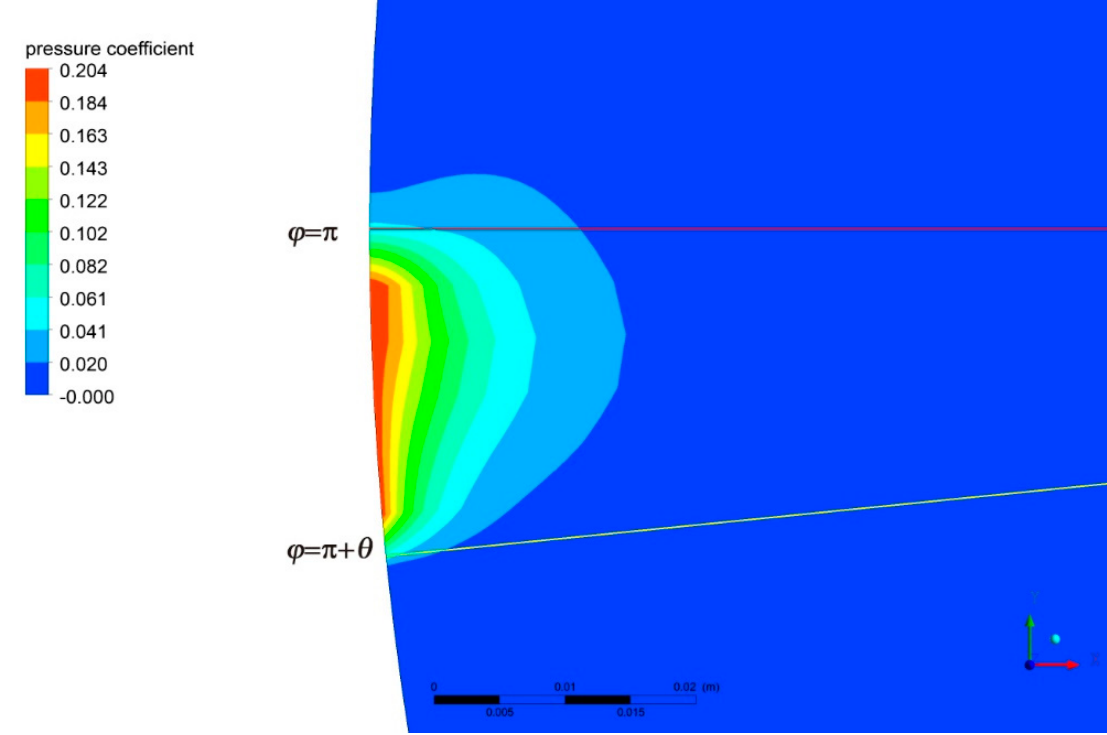
Figure 14. Pressure coefficient of case D at plane z / s = 0.5.